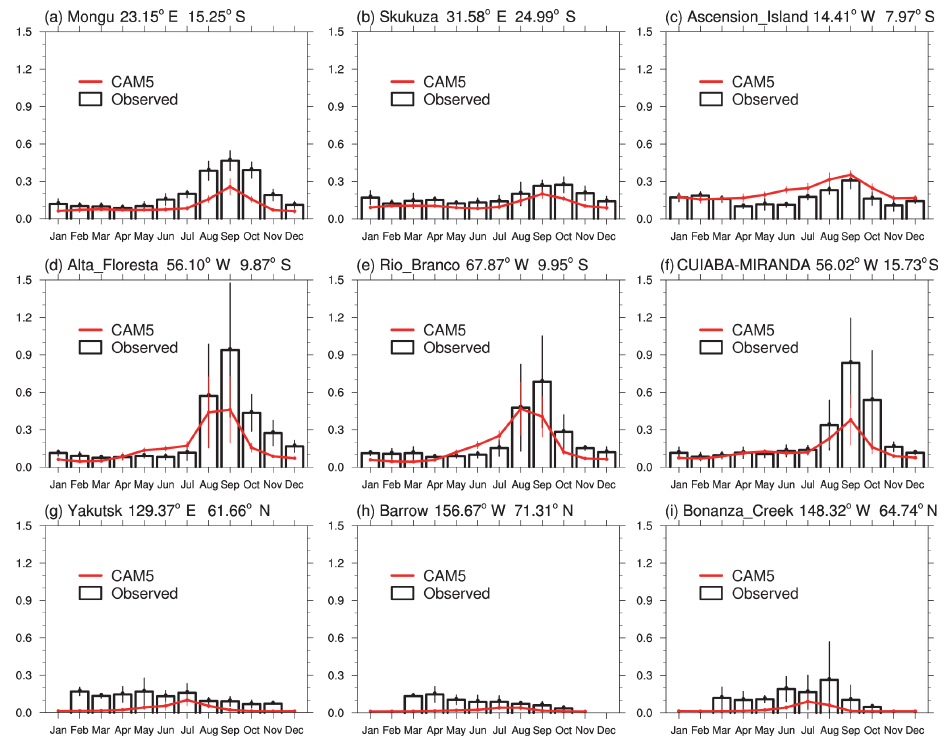
Figure 2. Comparison of modeled seasonal variations of aerosol optical depth (AOD) for the period of 2003–2011 with observations for the same period from the AERONET sites. The upper, middle and bottom panels represent the sites in southern Africa, South America and the Arctic. The vertical bars are ± 1 σ variabilities for the modeled and observed